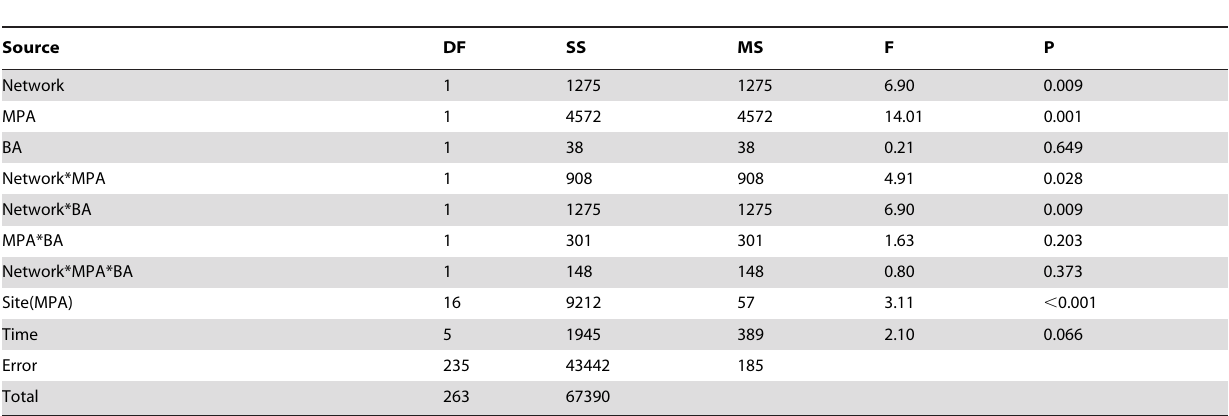
Table 2. Three-way analysis of variance of yellow tang abundance on West Hawai’i versus Maui (factor Network), within and outside protected areas (MPA), before (1999–2000) vs. after (2001–2003) network establishment on West Hawai’i (BA), and interactions among all fixed factors (see text for